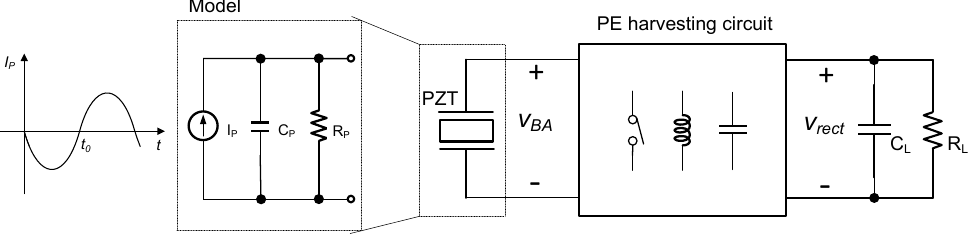
Figure 1. Piezoelectric (PE) energy harvesting system.